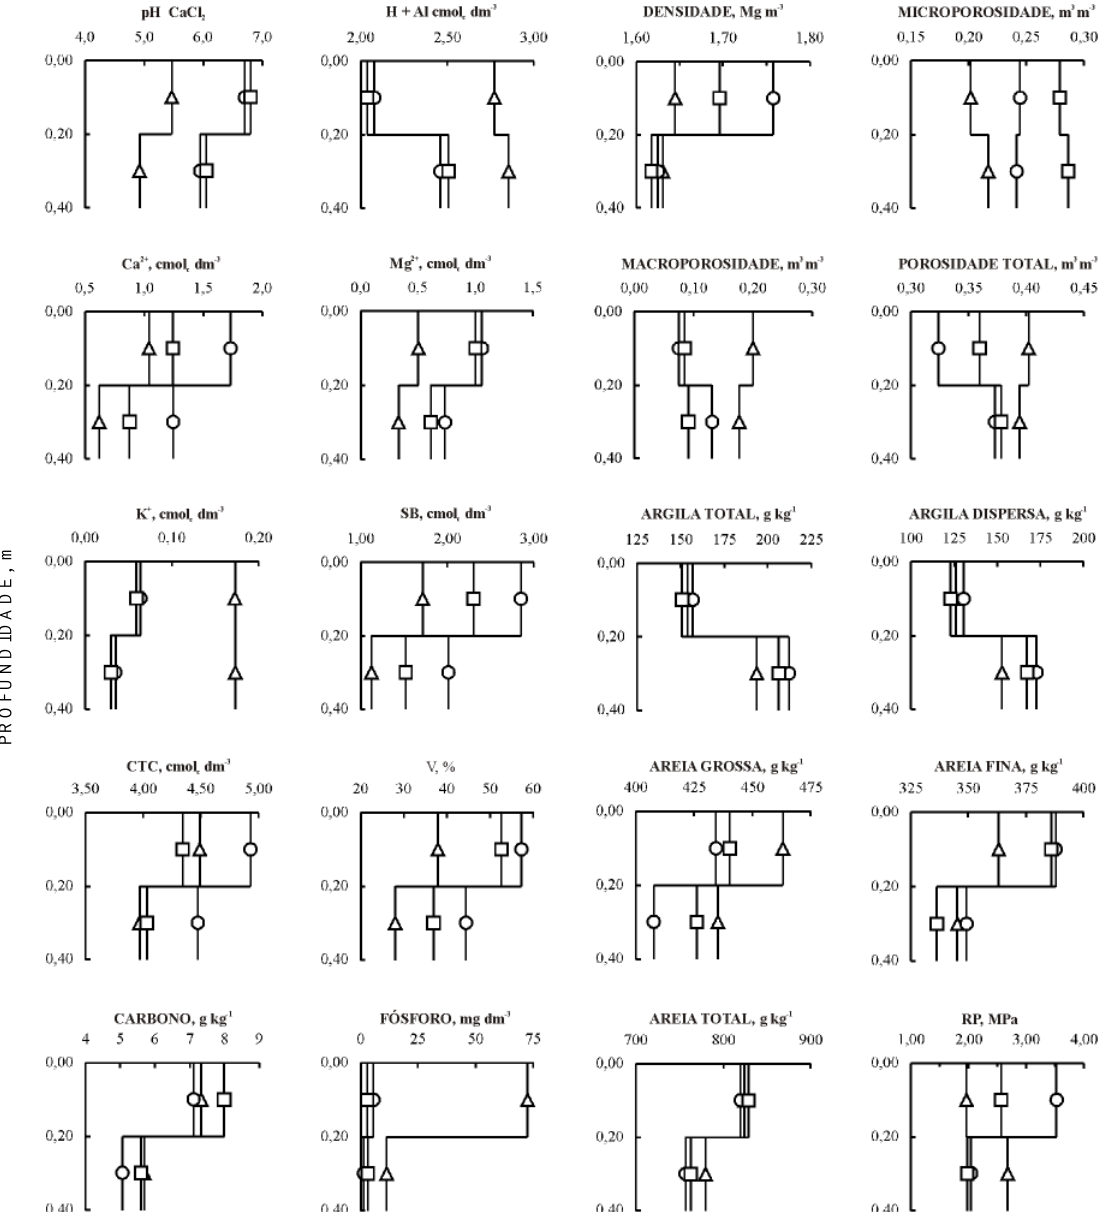
Figura 1. Indicadores de qualidade química e física do Latossolo Vermelho distrófico cultivado com laranjeira Valência, na projeção da copa da laranjeira ( ), no rodado da entrelinha ( ) e no centro da entrelinha ( ), para as camadas de 0–0,20 e 0,20–0,40 m de